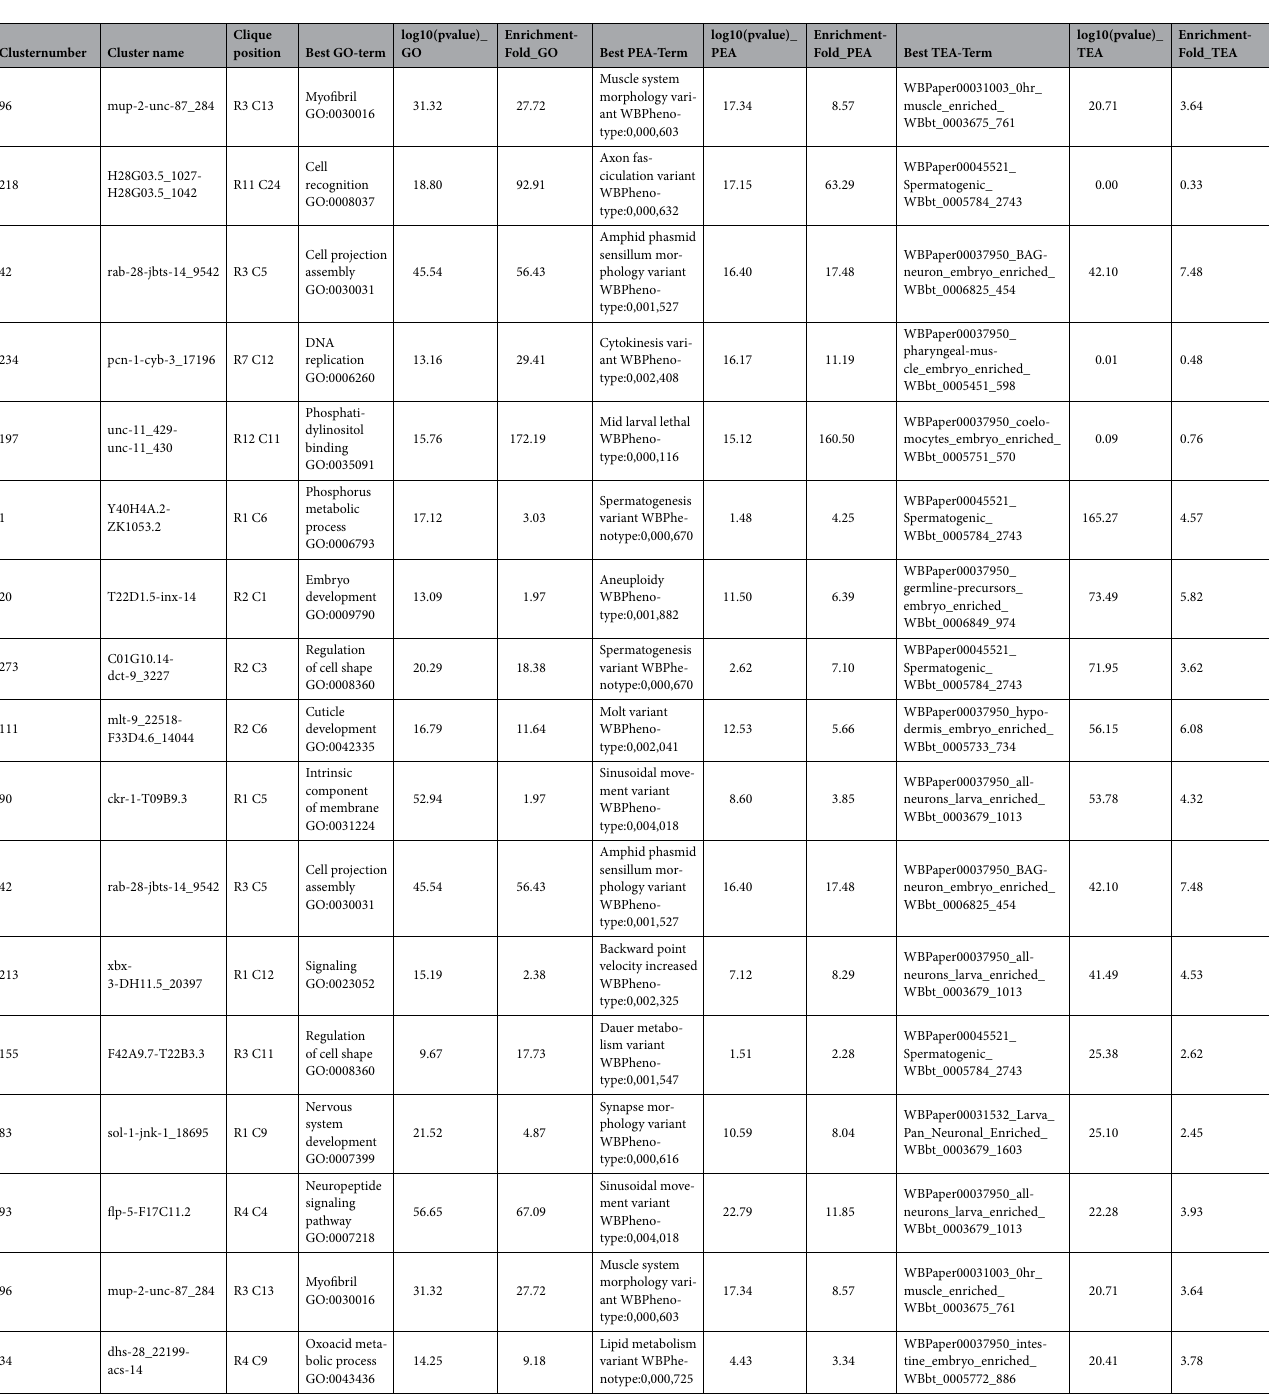
Table 1. Most relevant coexpression cliques of the clique map, their size and position, GO-term assignment, phenotype enrichment and tissue